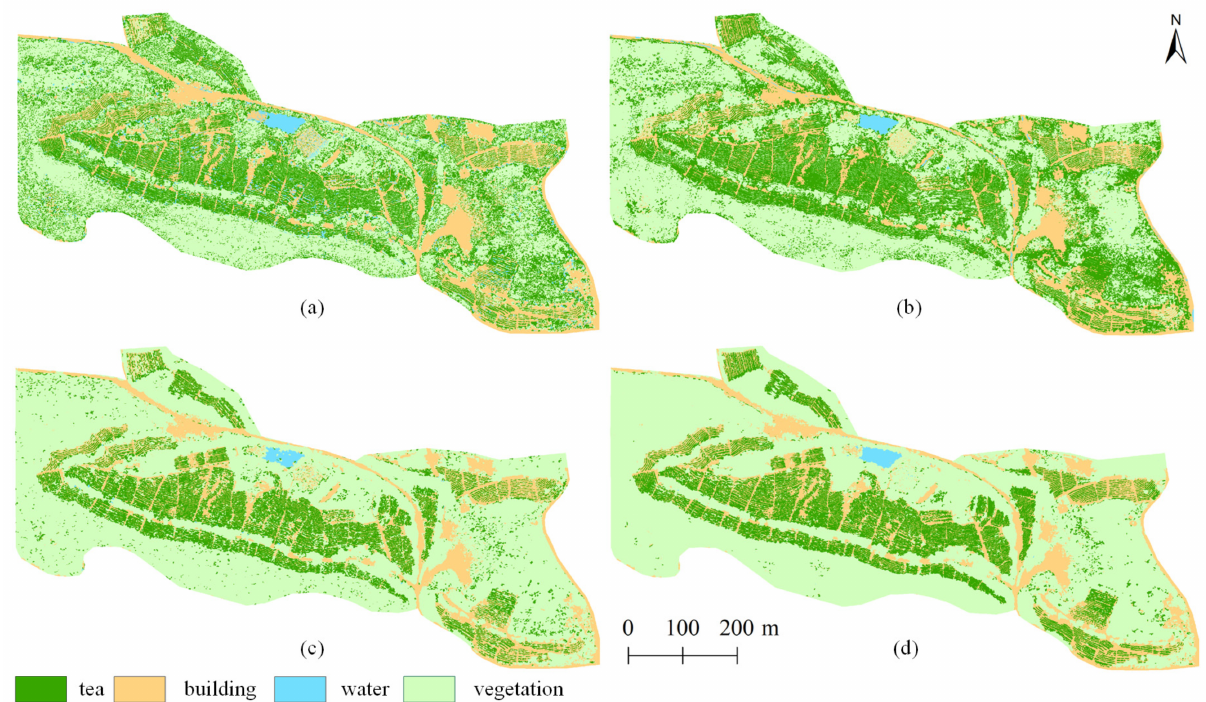
Figure 12. The classification results derived from the four models using RF. ( a ) Model 1; ( b ) Model 2; ( c ) Model 3; ( d ) Model